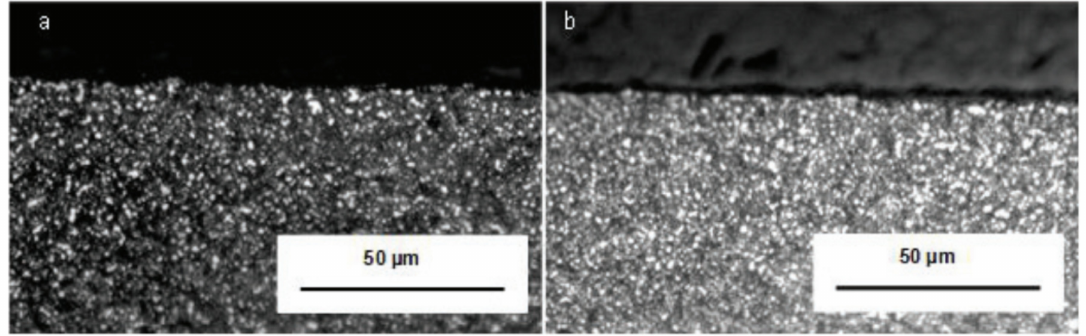
Figure 18. Microstructure after turning with VCGW160408 (positive). ( a ) Dry machining; ( b ) CO 2 machining, reprinted with permission from ref. [83]. Copyright 2015 Elsevier Ltd.